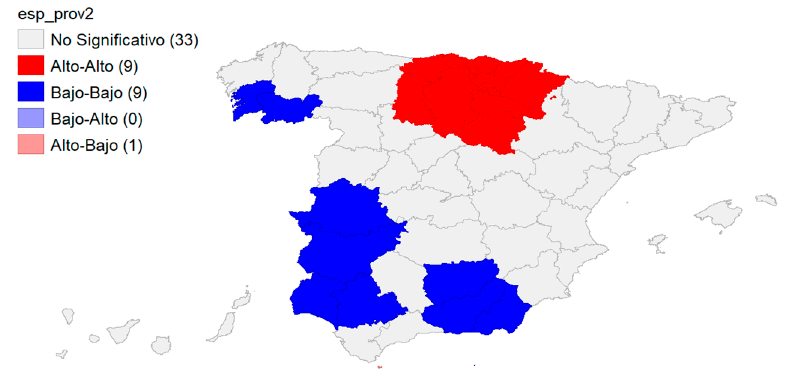
Figure 3. Clusters map for province specialization.